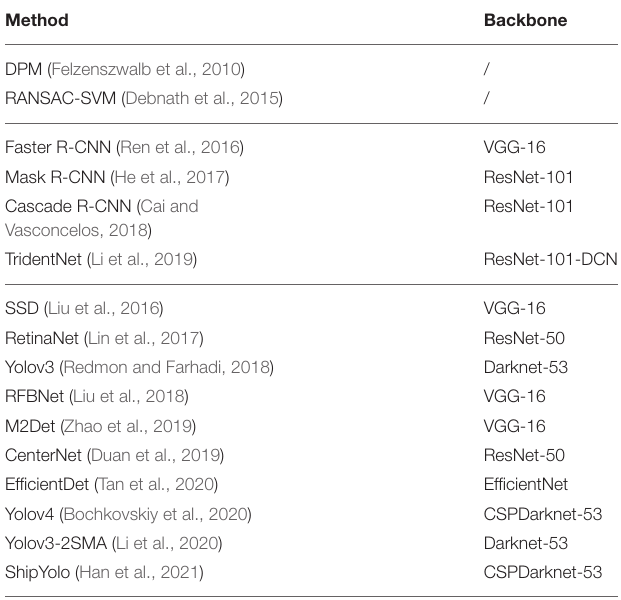
TABLE 3 | Sixteen benchmark testing methods and their backbones.